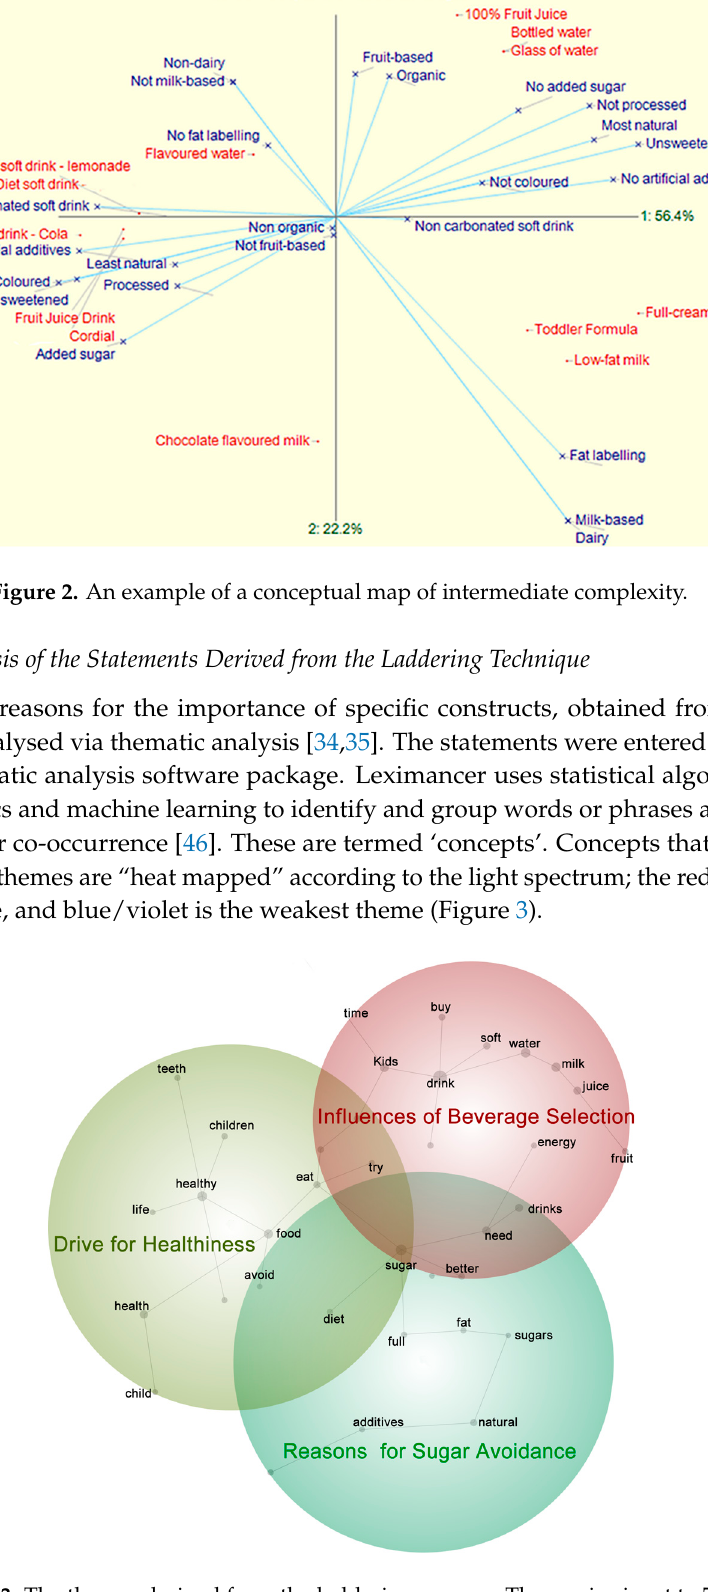
Figure 3. The themes derived from the laddering process. Theme size is set to 70%.